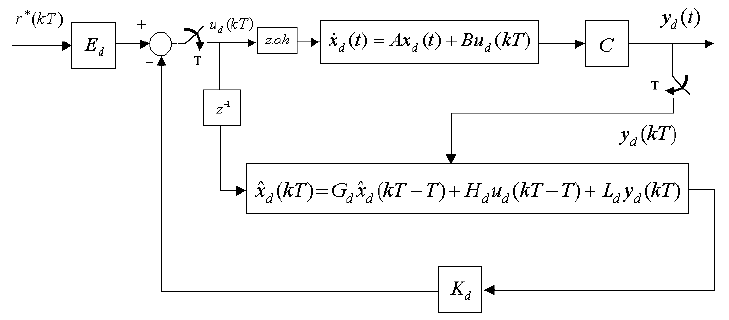
Figure 2. Practically implemented full-order observer for the sampled-data linear system.